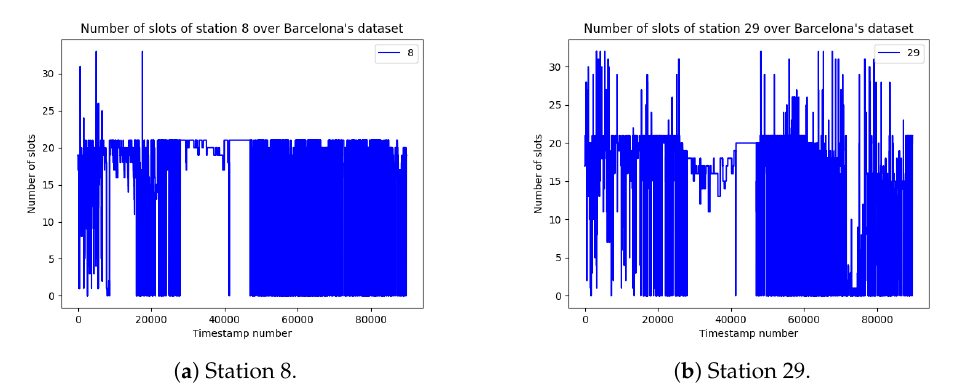
Figure 4. Total number of slots of stations over time.